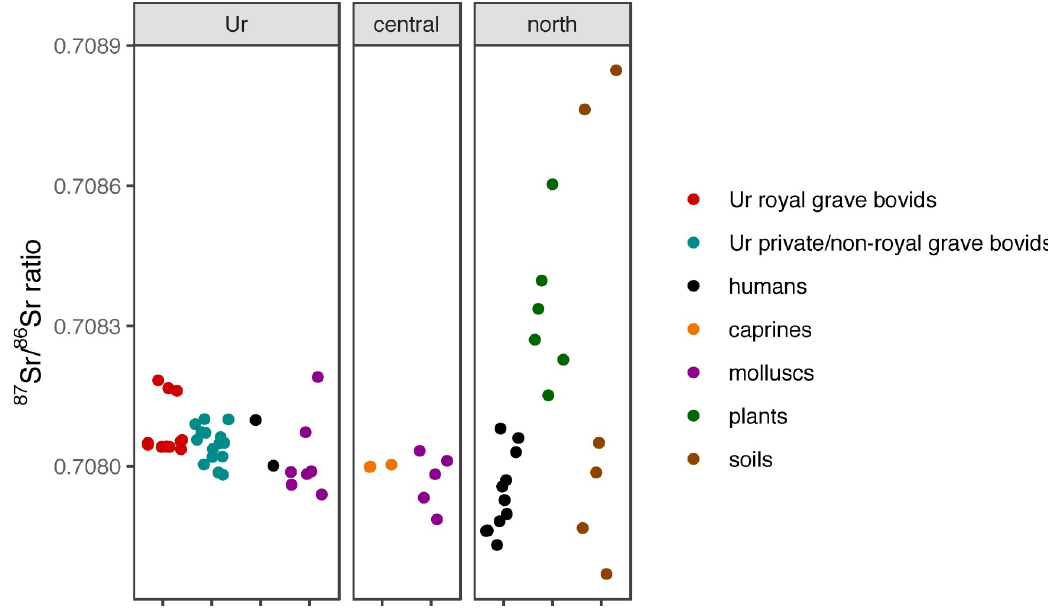
Fig 7. (animal_Sr4.eps): Enamel strontium isotope results from the bovines from Ur compared to those from humans, caprines, molluscs, plants and soils from the Mesopotamian region. See text for full details.